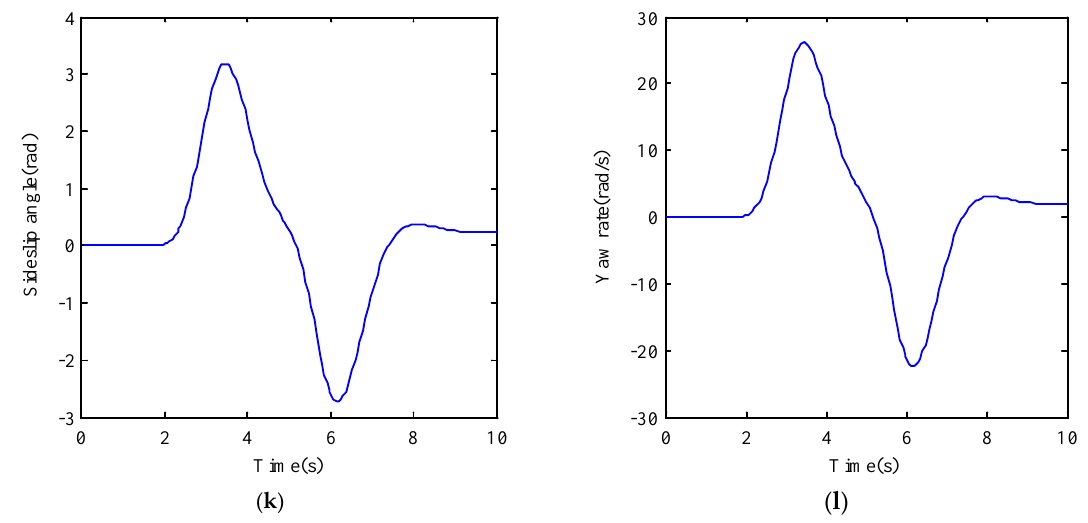
Figure 6. Double lane change simulation at 20 m/s ( a ) Steering wheel steering angle curve; ( b ) Sideslip angle curves of SSV; ( c ) Sideslip angle curves of DSV; ( d ) Yaw rate curves; ( e ) Sideslip angle curves; ( f ) Differential driving torque for skid steering; ( g ) Differential driving torque for differential steering; ( h ) Front wheel steering angle; ( i , j ) Response curves of SSV without SMC controller; ( k , l ) Response curves of DSV without SMC controller.